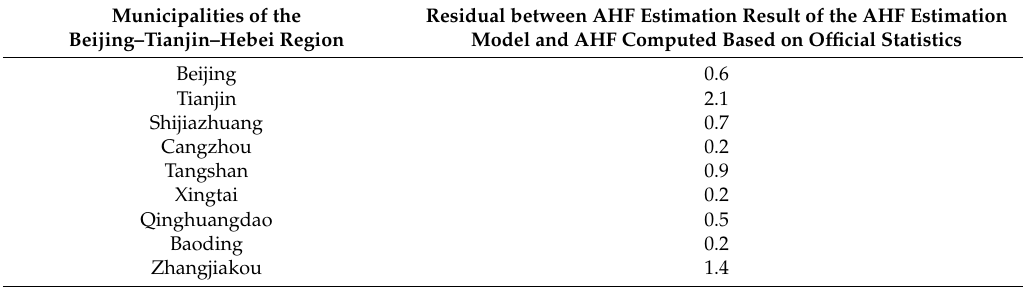
Table 3. Comparison between the AHF estimation results and the AHF computed based on official